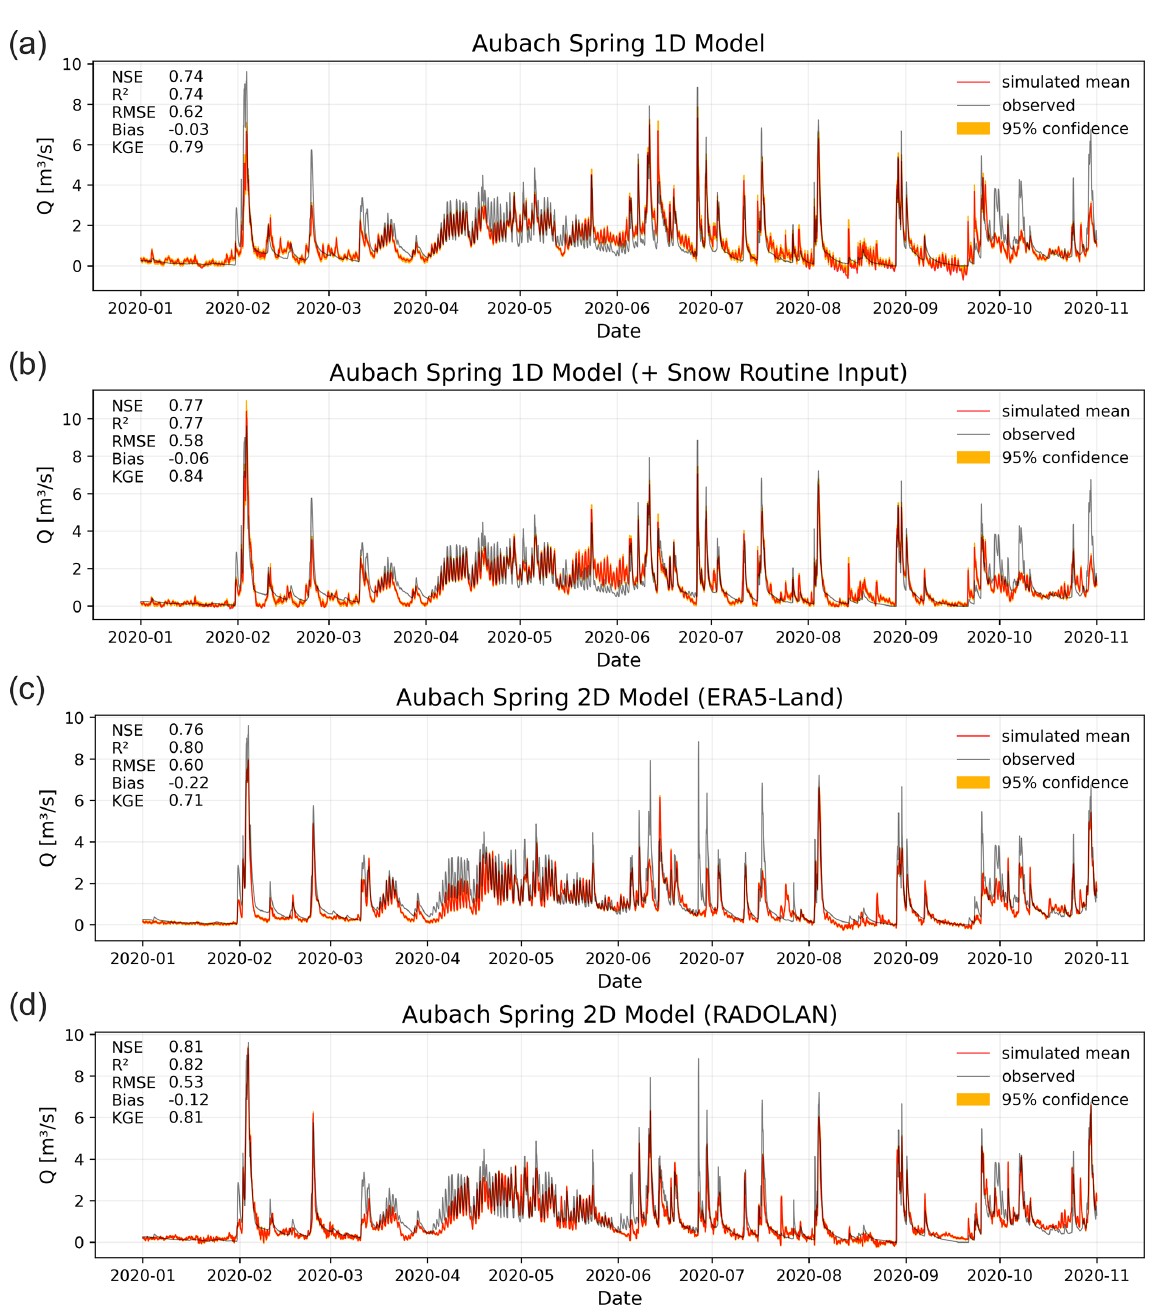
Figure 3. Simulation results for the year 2020 at Aubach spring: (a) 1D model based on climate station inputs, (b) 1D model with additional snow routine preprocessing, (c) 2D model based on ERA5-Land gridded data and (d) 2D model with combination of ERA5-Land data and RADOLAN precipitation